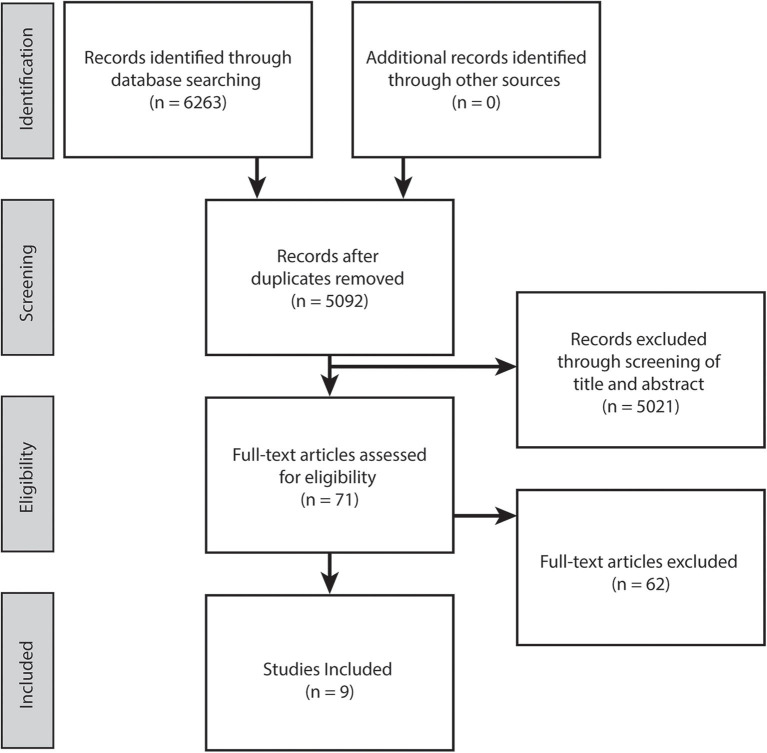
PRISMA flow diagram.